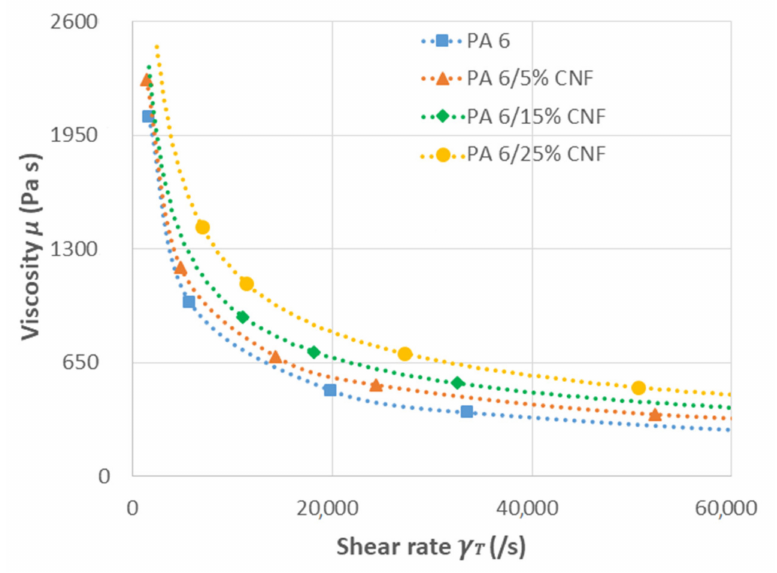
Figure 4. Rheological behavior of neat PA 6 and PA 6/CNF